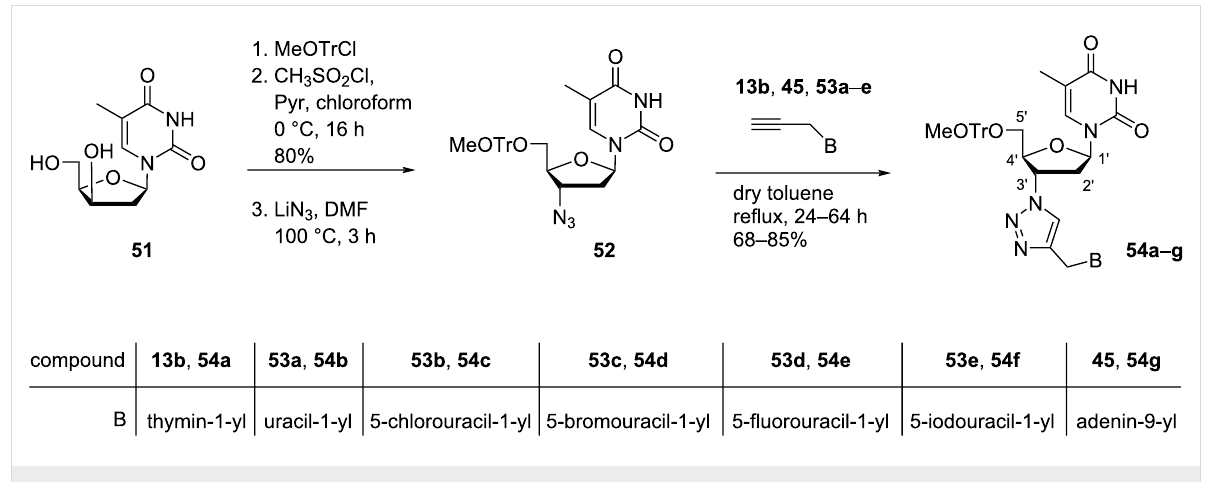
Scheme 12: Synthesis of double-headed nucleosides 54a–g